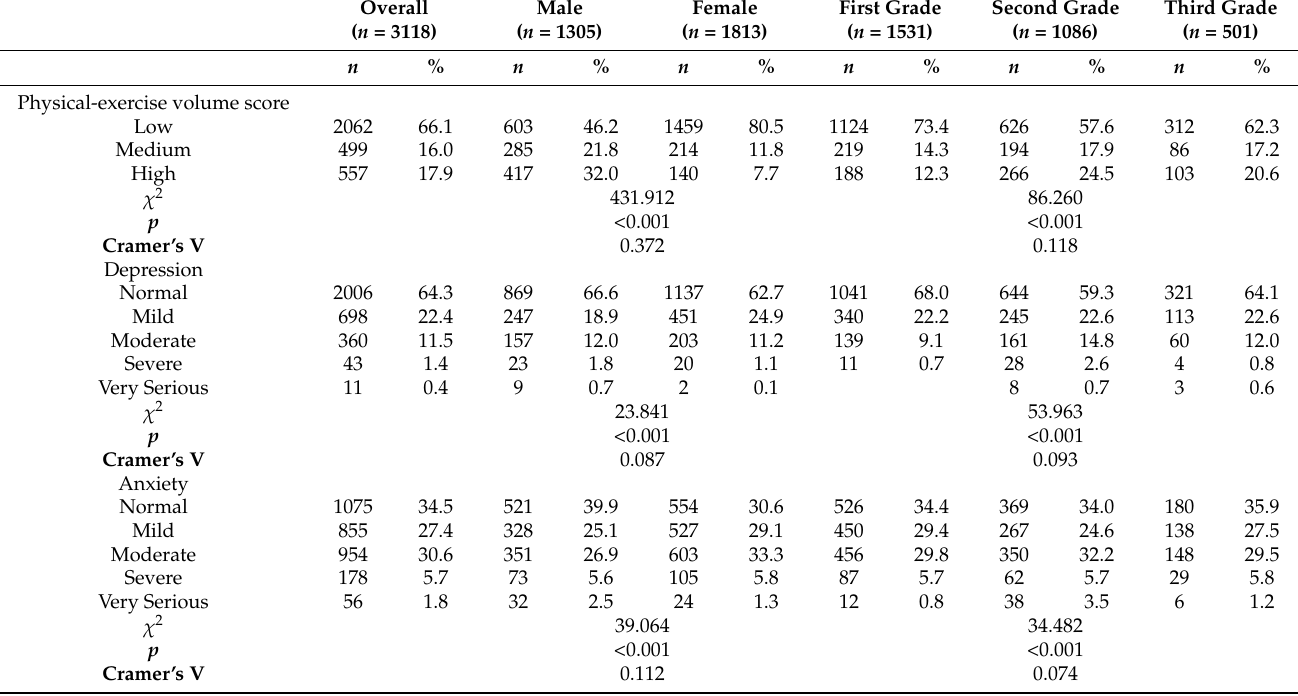
Table 1. Status sex and grade differences of college students’ negative emotions and physical